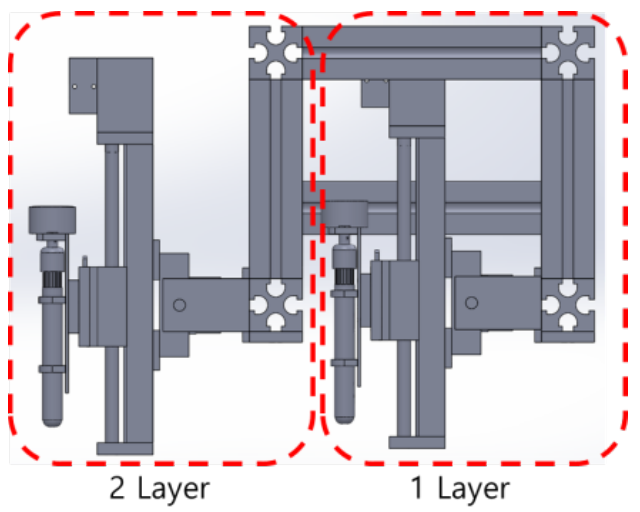
Figure 8. Multi-layer mechanical unit with a vertically arranged structure (side view) .